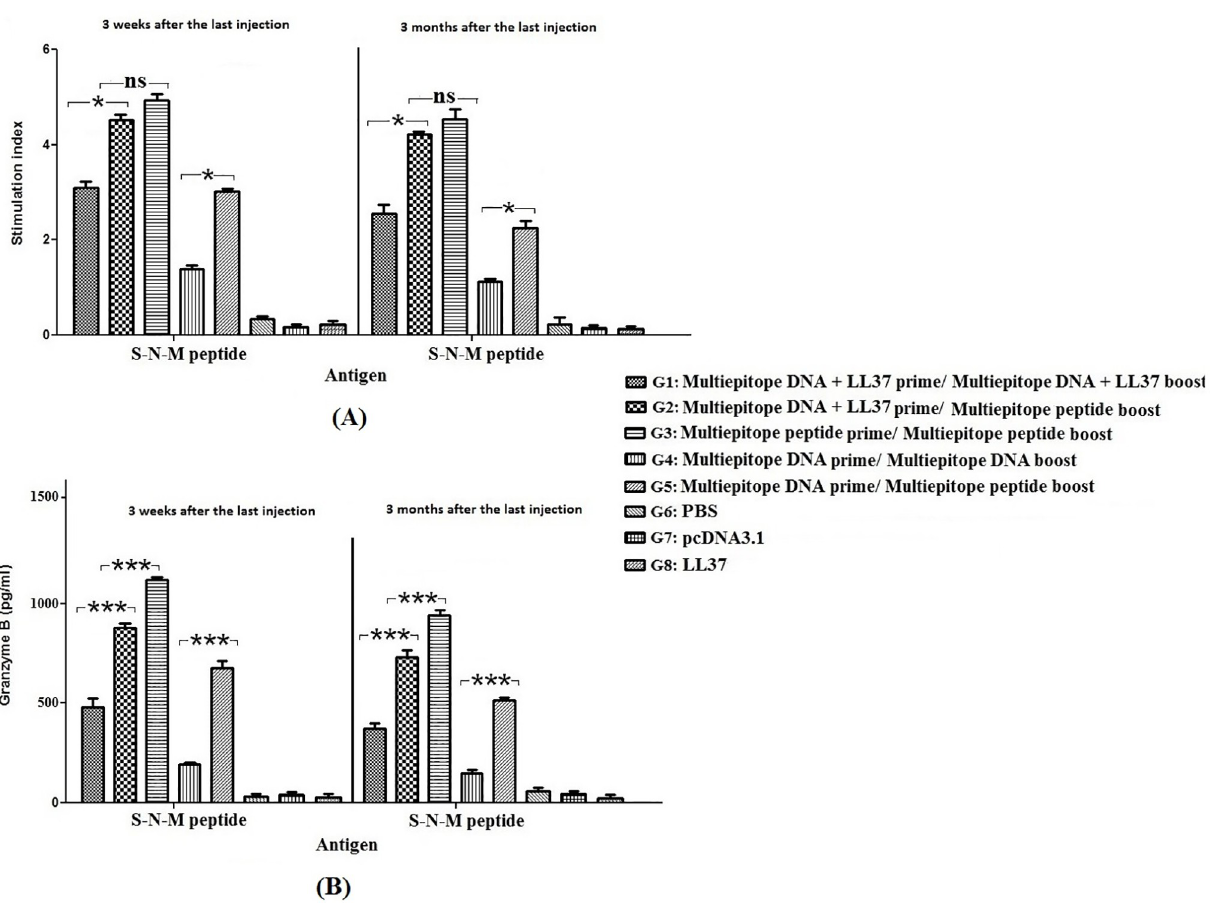
Fig 9. The lymphocyte proliferation (A) and Granzyme B concentration (B) in immunized groups with S-N-M antigen in various formulations. The Granzyme B concentration was determined as the mean absorbance at 450 nm ± SD from three independent experiments. Significant differences were shown by � p < 0.05, �� p < 0.01, ��� p < 0.001, and non-significant difference was shown by ns ( p >